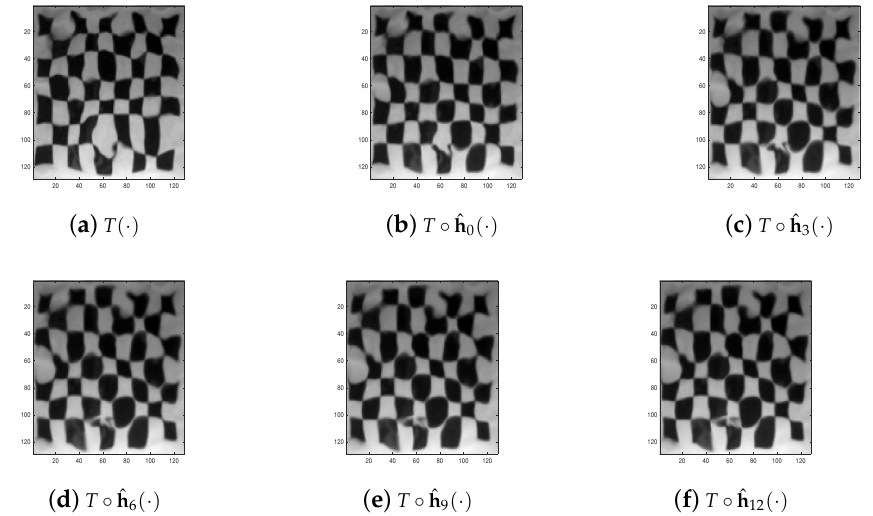
Figure 12. Registration result for different scales on image pairs of Underwater square. ( a ) T ( · ) . ( b ) Re − SSD = 19.32%. ( c ) Re − SSD = 3.79%. ( d ) Re − SSD = 2.16%. ( e ) Re − SSD = 1.69%. ( f ) Re − SSD =